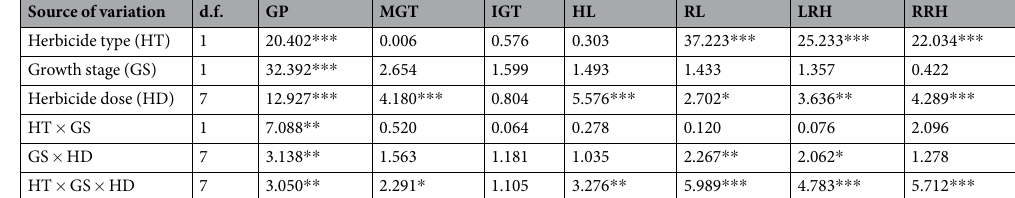
Table 1. MANOVA results ( F values) for testing for different growth stages of parent plants treated by herbicide, herbicide type, dose and their interactions on germination and 7-day-old seedlings growth of A. retroflexus F1 generation. GP = germination percent; MGT = mean germination time; IGT = initial germination time; HL = hypocotyl length; RL = radicle length; LRH = the length of radicle and hypocotyl; RRH = the ratio of radicle length to hypocotyl length. d.f.: degrees of freedom; ns: not significant; * P < 0.05; ** P < 0.01; *** P <